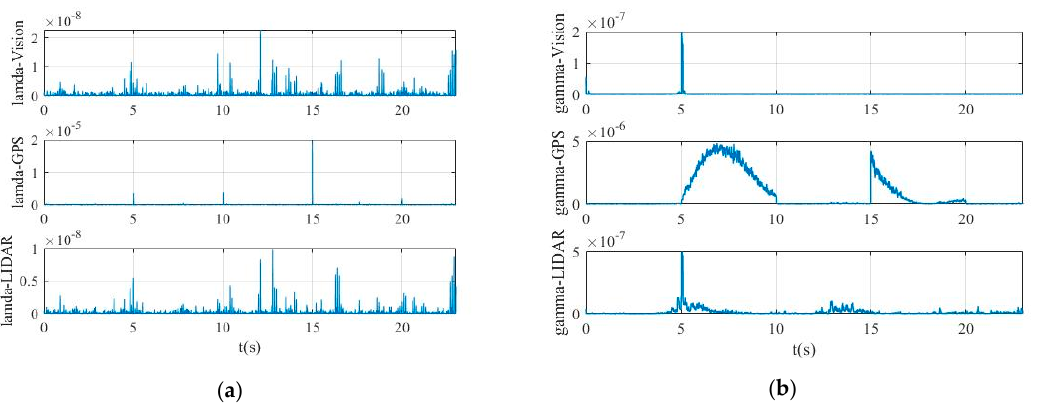
Figure 13. The changes of fault detection function for yaw angles in experiment based on: ( a ) double state chi-square detector; and ( b ) residuals chi-square detector.